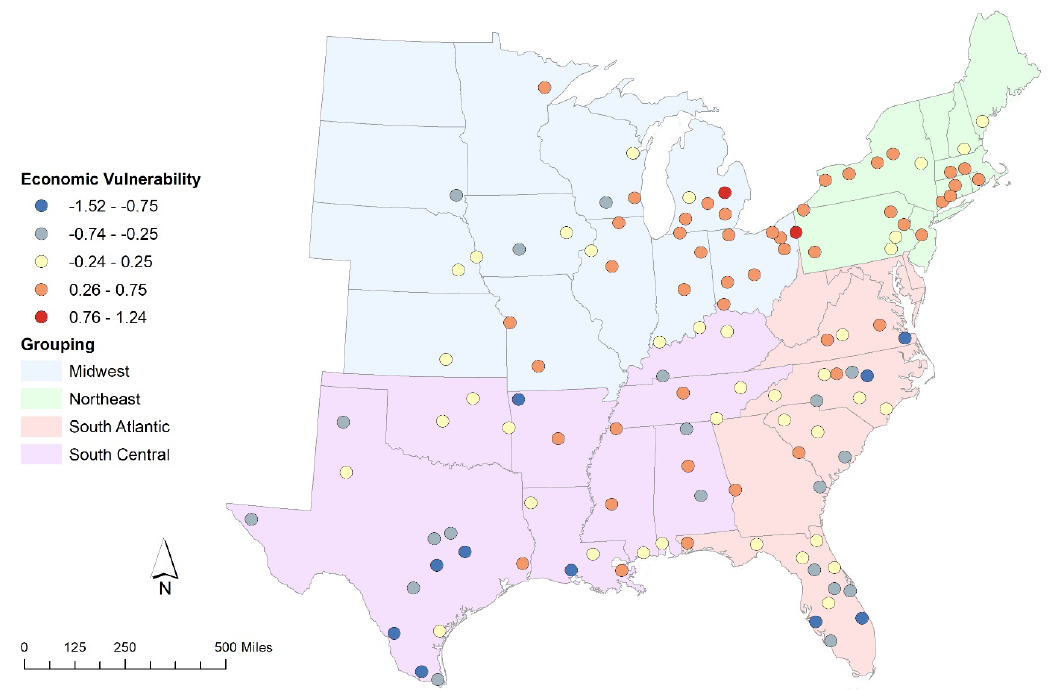
Figure 3. Economic vulnerability z-scores for each urban